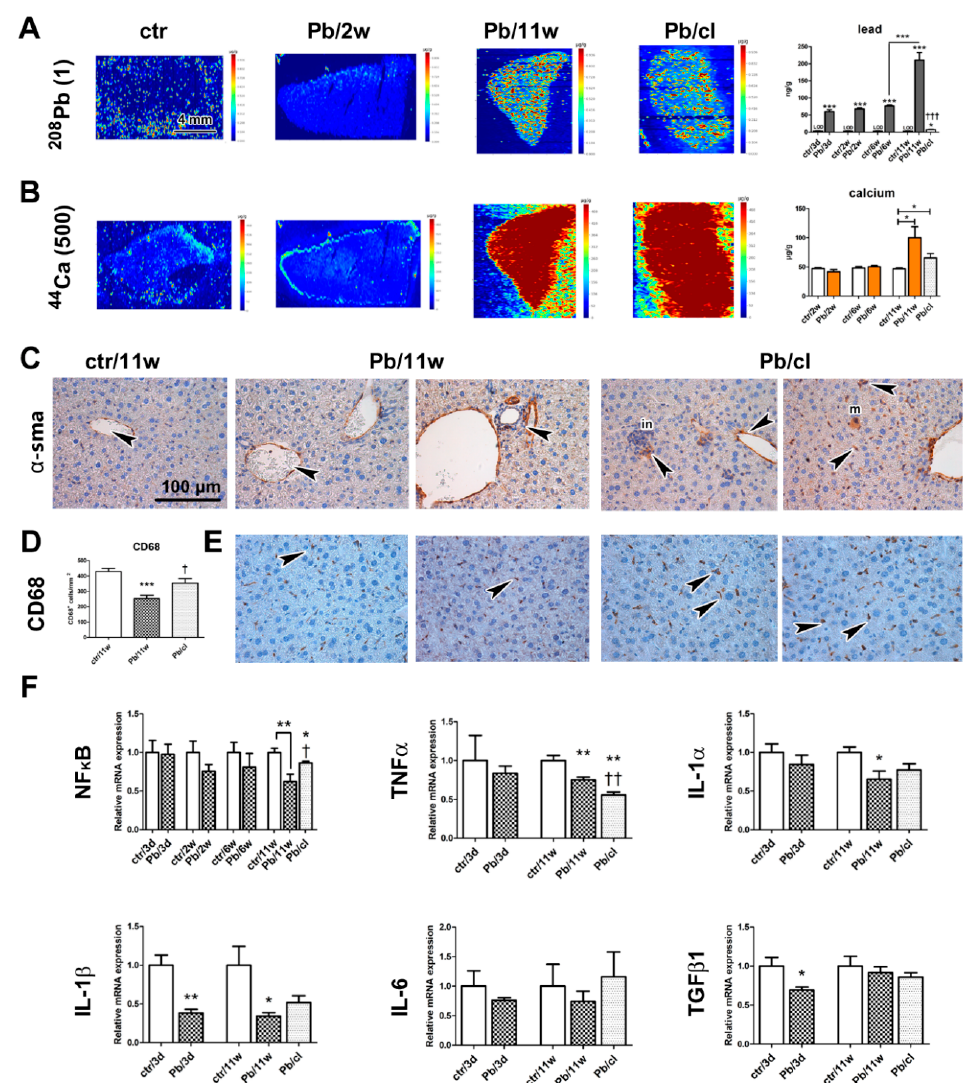
Figure 7. The distribution of selected metals at designated time points after Pb(NO 3 ) 2 NP inhalation in the liver, and immunohistochemical analyses of liver. ( A ) Distribution of Pb in liver samples using laser ablation and inductively coupled plasma mass spectrometry (LA-ICP-MS). The graph of Pb level in the liver at designated time points. ( B ) Distribution of Ca in liver samples using LA-ICP-MS. The graph of Ca level in the liver at designated time points. The graphs values denote average ± SD for 5 mice/group, * p < 0.05, *** p < 0.001 compared with the corresponding control group (or between adjacent time points), and ††† p < 0.001 compared with the corresponding Pb(NO3)2 NP group by unpaired t -test. LOD for Pb in the liver was 3 ng/g. Numbers in parentheses show maximal value (µg/g) of elements on a scale. Scale bar in panels ( A , B ) = 4 mm. ( C ) Immunohistochemical detection of alpha-smooth muscle actin ( α -SMA) signal was located in the walls of blood vessels in control (arrowhead), and additionally α -SMA-positive cells were observed in liver parenchyma after Pb(NO 3 ) 2 NP inhalation (arrowheads), megakaryocyte (m) and focal infiltrate (in). ( D ) Statistical evaluation of the number of CD68-positive cells after Pb(NO 3 ) 2 NP inhalation. The graphs values denote average ± SD; *** p < 0.001 compared with the corresponding controls, and † p < 0.05 compared with the Pb(NO 3 ) 2 NP group by unpaired t -test. ( E ) Detection of CD68-positive cells (marker of macrophages) in liver (arrowheads). Scale bar in panels ( C , E ) = 100 µ m. ( F ) Gene expression of nuclear factor κ B ( NF- κ B ) and cytokines at selected time points after Pb(NO 3 ) 2 NP inhalation. The graphs values denote average ± SD for 4-5 mice / group, * p < 0.05, ** p < 0.01 compared with the corresponding control group; † p < 0.05, †† p < 0.01 compared with the corresponding Pb(NO 3 ) 2 NP group by unpaired t